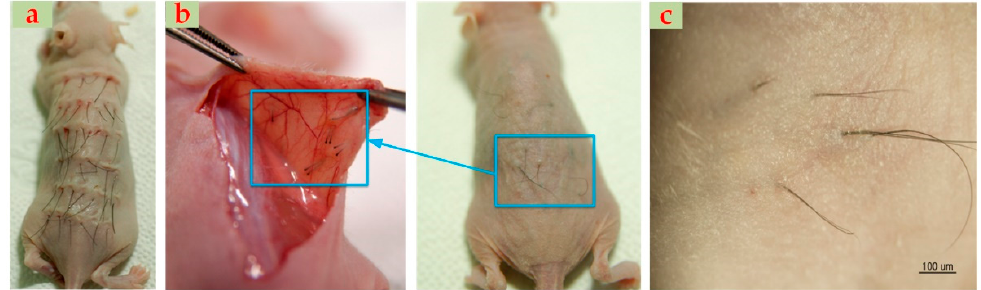
Figure 13. Animal experiment result. ( a ) nude mouse, ( b ) regrown HFs, and ( c ) regrown hair.